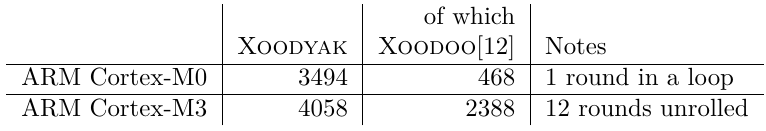
Table 5: Code sizes (in bytes) of our implementations of Xoodyak and of the permutation